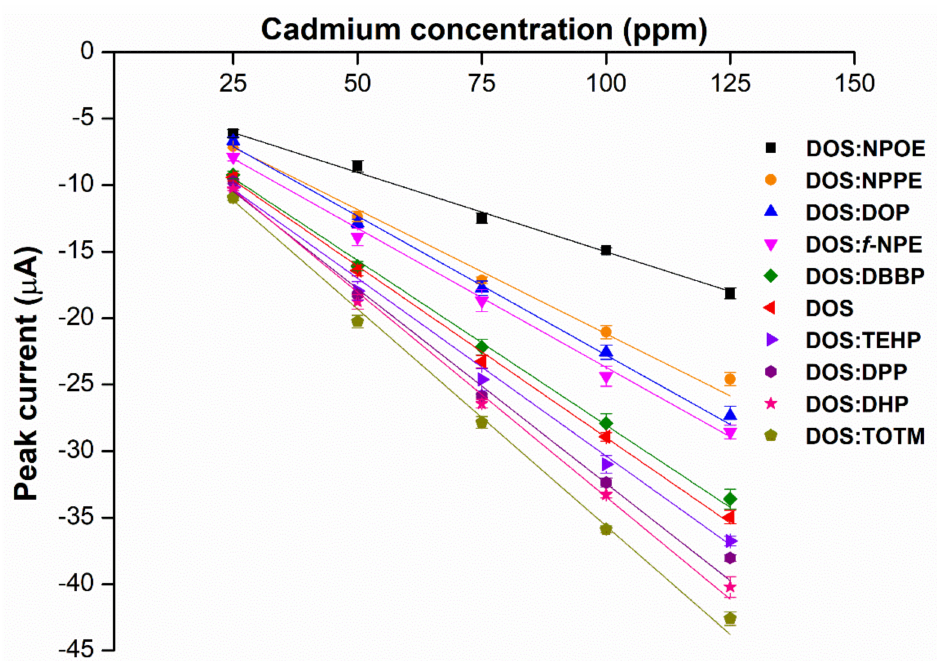
Figure 4. Relationship between peak current of the different types of hybrid plasticizer sensors and the different concentrations of cadmium(II), ( n =